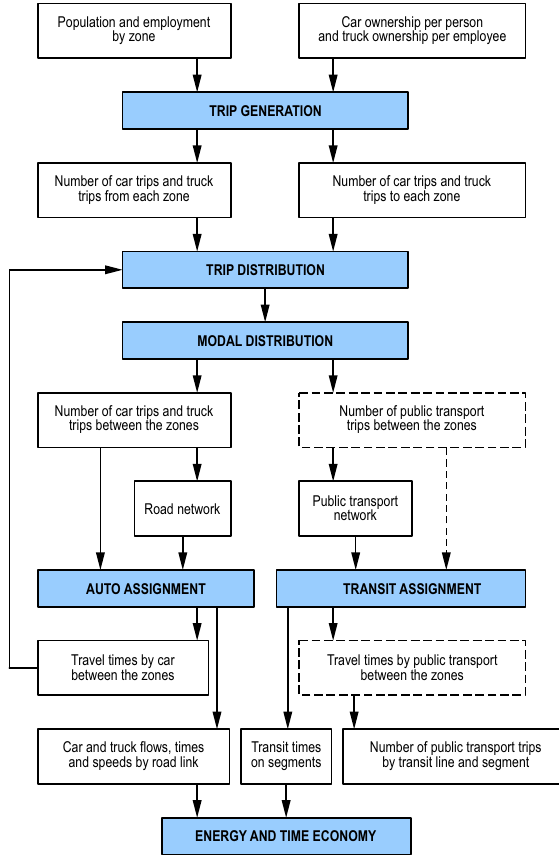
Fig. 2. Modelling